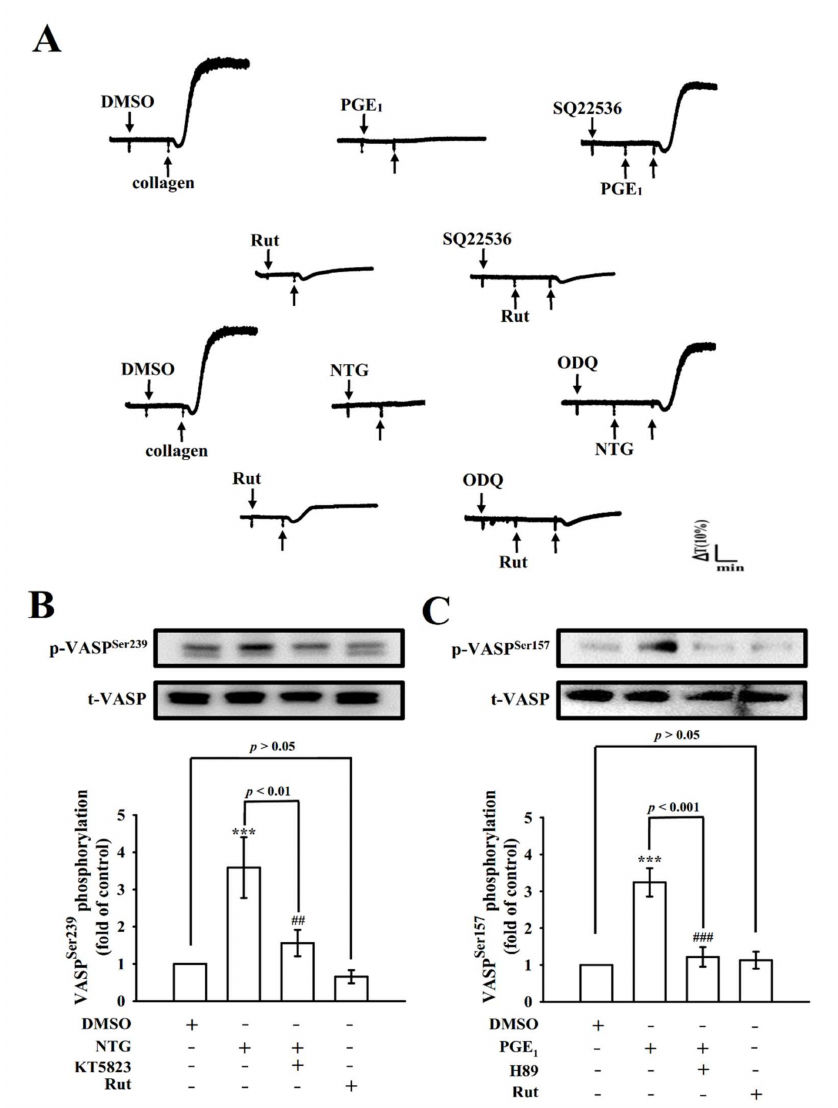
SQ22536 nor ODQ could reverse Rut (5 µ M)-mediated antiplatelet activity. Moreover, NTG (20 µ M) and PGE 1 (20 nM) triggered the phosphorylation of VASP Ser239 (Figure 6B) and VASP Ser157 (Figure 6C), respectively. Treatment with KT5823 (a protein kinase G inhibitor; 10 µ M) and H89 (a protein kinase A inhibitor; 100 µ M) markedly reduced VASP Ser239 and VASP Ser157 phosphorylation (Figure 6B,C), respectively. However, Rut (5 µ M) exerted no significant effect on both VASP phosphorylations, indicating that Rut has an antiplatelet mechanism without involvement of cyclic nucleotide in washed human platelets.